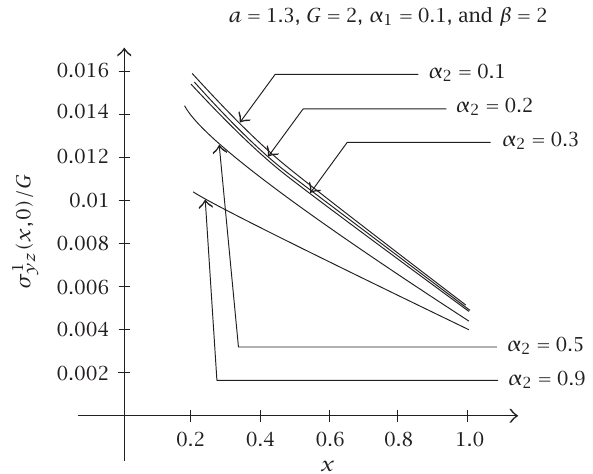
x for different values of 1 with = 0 . 1, and β = 2. 1